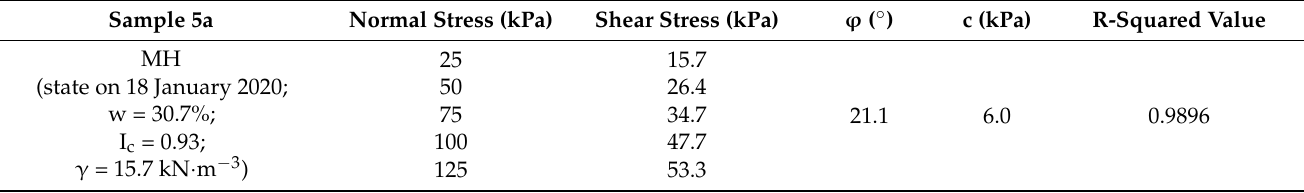
Table 3. Water content, unit weight, and shear strength parameters of soil sample